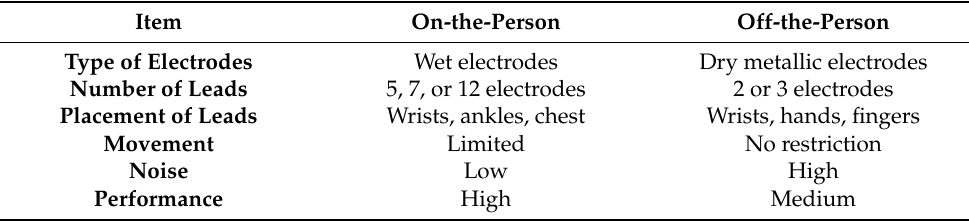
Table 3. Comparison of on-the-person and off-the-person acquisitions (adapted from [58]). Item On-the-Person Off-the-Person Type of Electrodes Wet electrodes Dry metallic electrodes Number of Leads 5, 7, or 12 electrodes 2 or 3 electrodes Placement of Leads Wrists, ankles, chest Wrists, hands, fingers Movement Limited No restriction Noise Low High Performance High Medium Number of